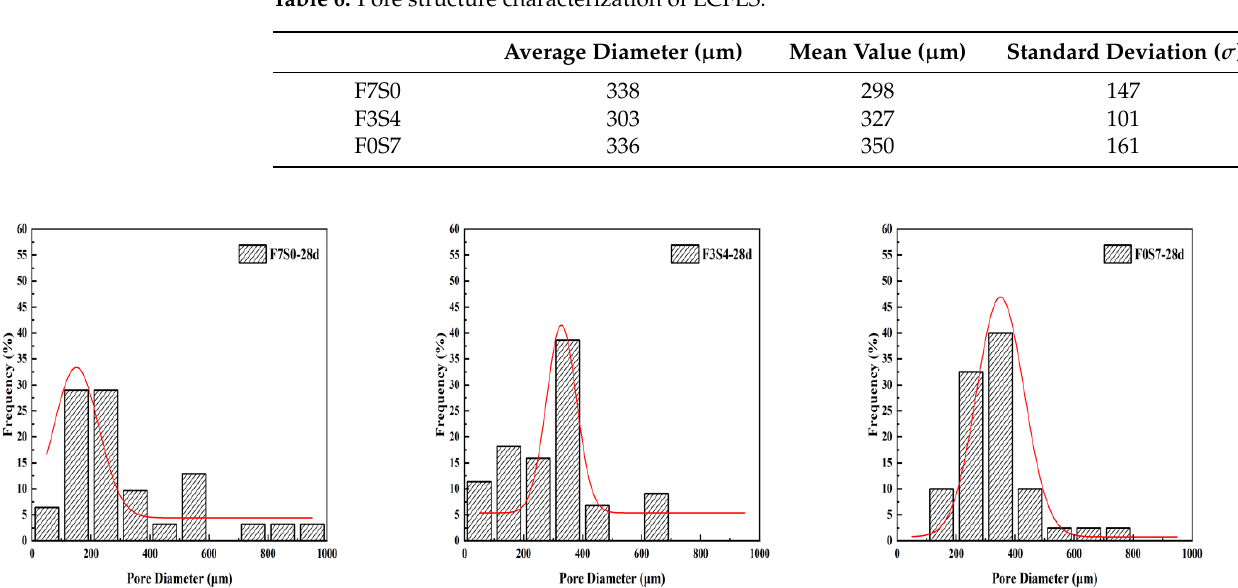
Figure 9. Pore size distributions of LCFLS.